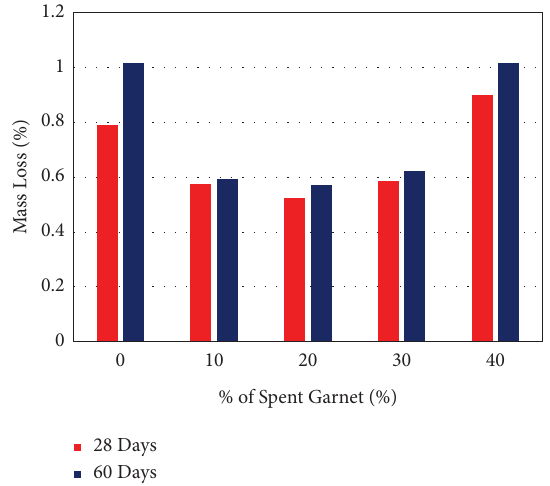
Figure 22: Mass loss of POC LWAC due to acid attack.